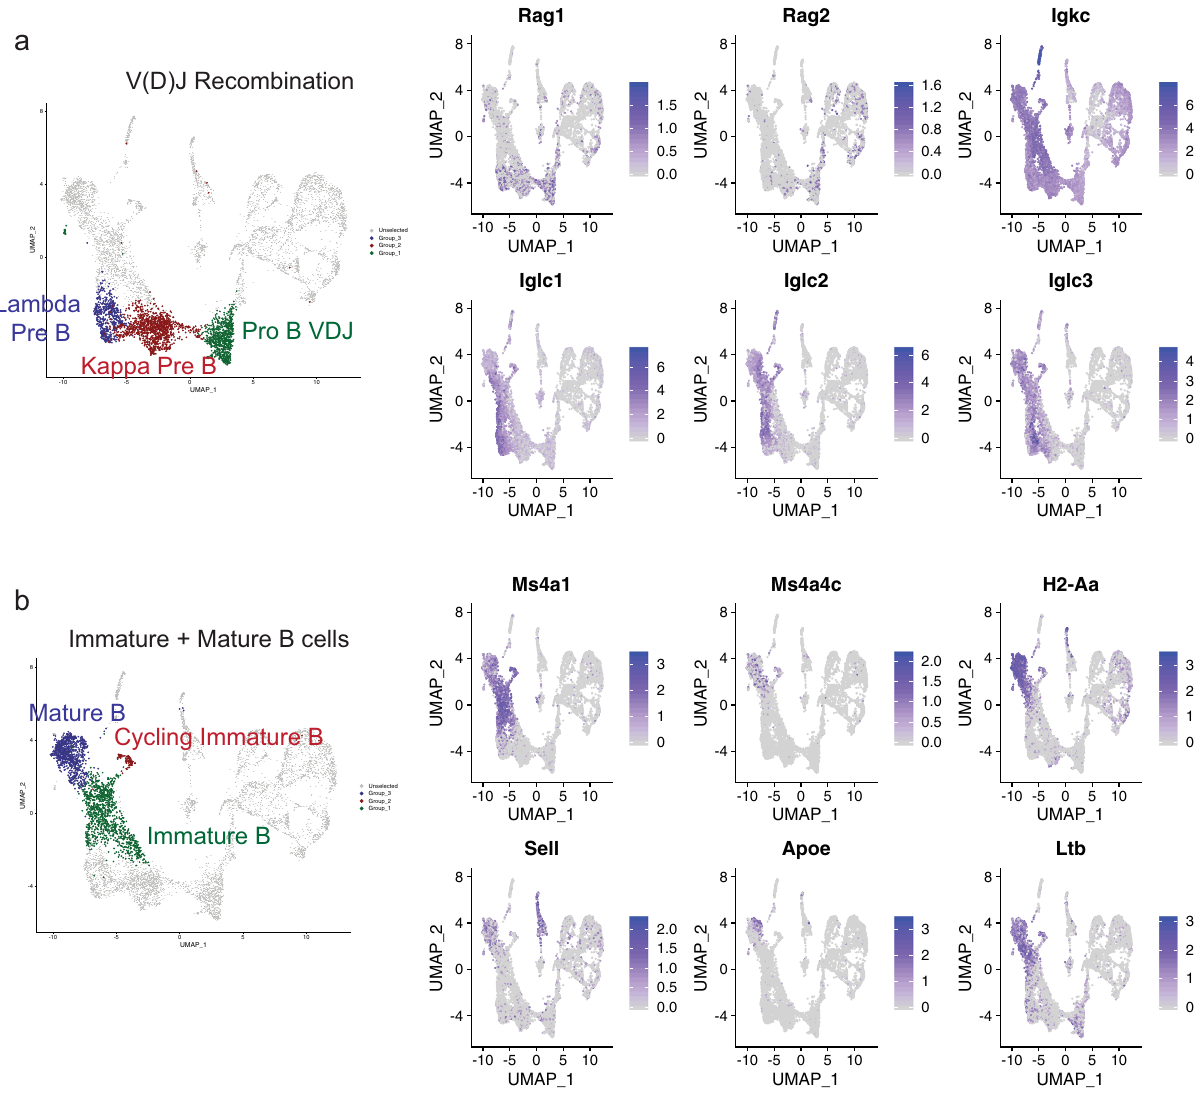
Fig. 5 B-cell differentiation and maturation. a Highlighted B-cell clusters undergoing V(D)J recombination (left). Feature plot of genes involved in V(D)J recombination or speci fi c for pre-B-cell expression (right). b Highlighted B-cell clusters for late B-cell maturation (left). Feature plot of genes highly expressed in immature or mature B cells (right). Color scale in a,b represents normalized counts centered and scaled across